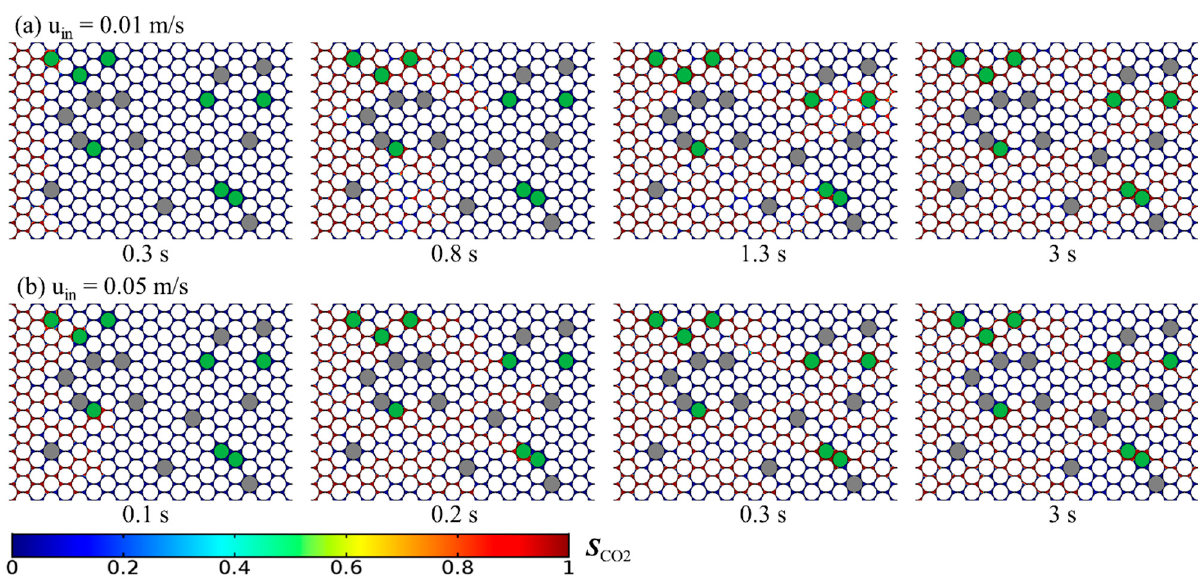
Figure 7. Temporal evolution of CO 2 distribution under the near-miscible condition at the CO 2 injection velocity of ( a ) 0.01 m/s and ( b ) 0.05 m/s.